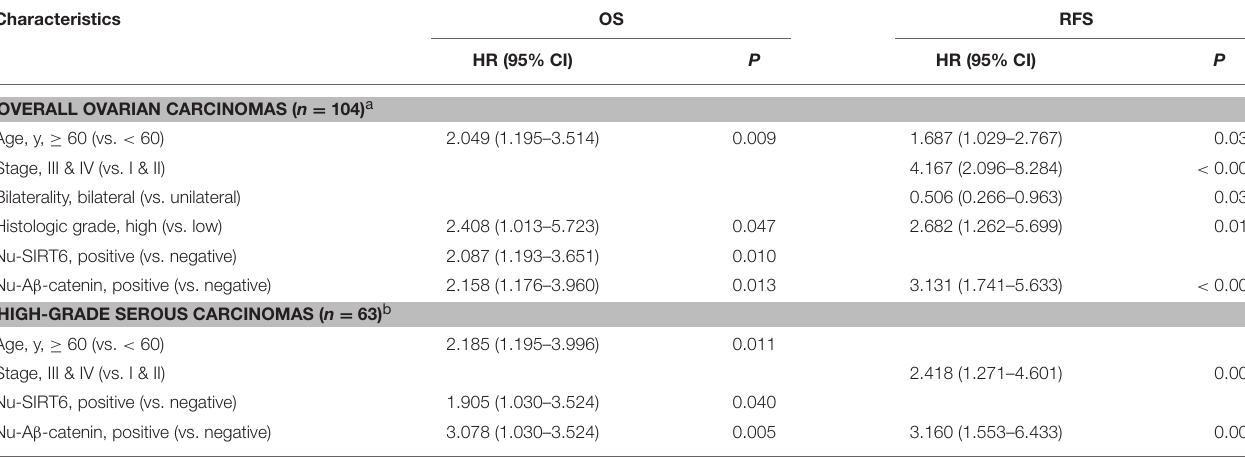
TABLE 4 | Multivariate Cox regression analyses for overall survival and relapse-free survival in 104 ovarian carcinomas and 63 high-grade serous carcinomas. Characteristics OS